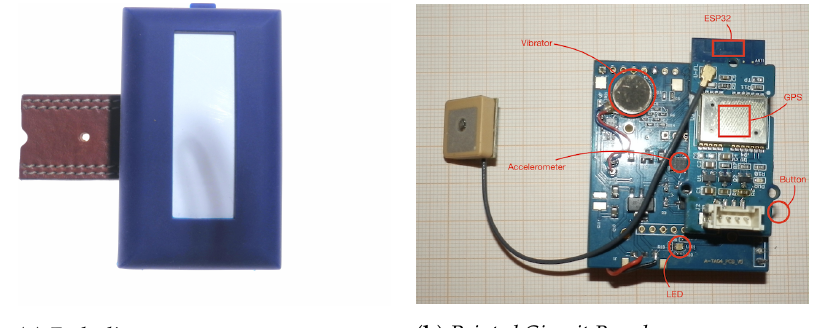
Figure 9. Belt-Device